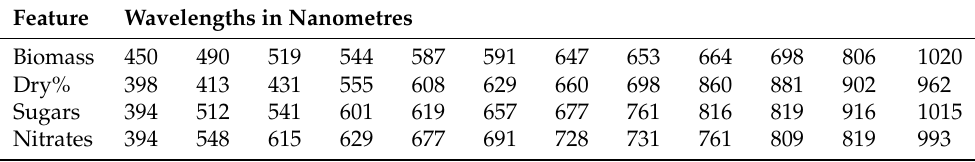
Table 1. Wavelengths in nanometres are identified as important for each target variable.